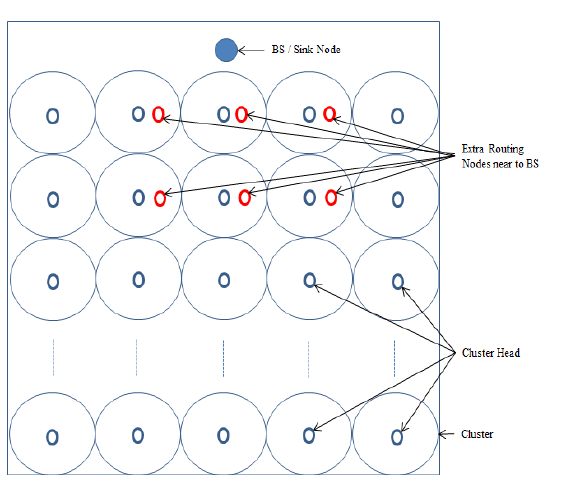
Figure 17. Extra routing nodes near to